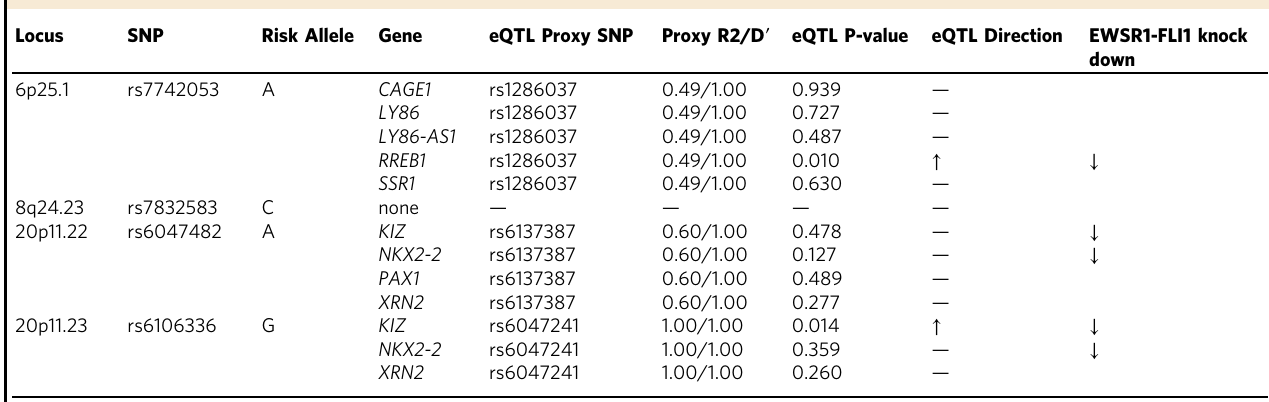
Table 2 Functional associations for newly identi fi ed EWS susceptibility loci